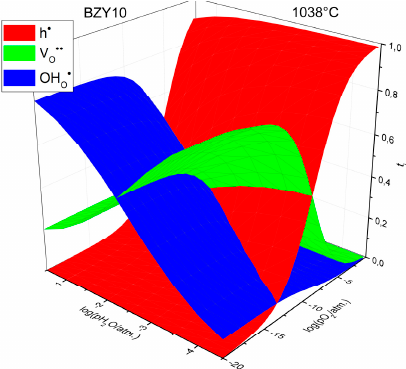
Figure 4. Transference numbers of charge carriers in BZY10 depending on p O 2 and p H 2 O at 1038 °C.